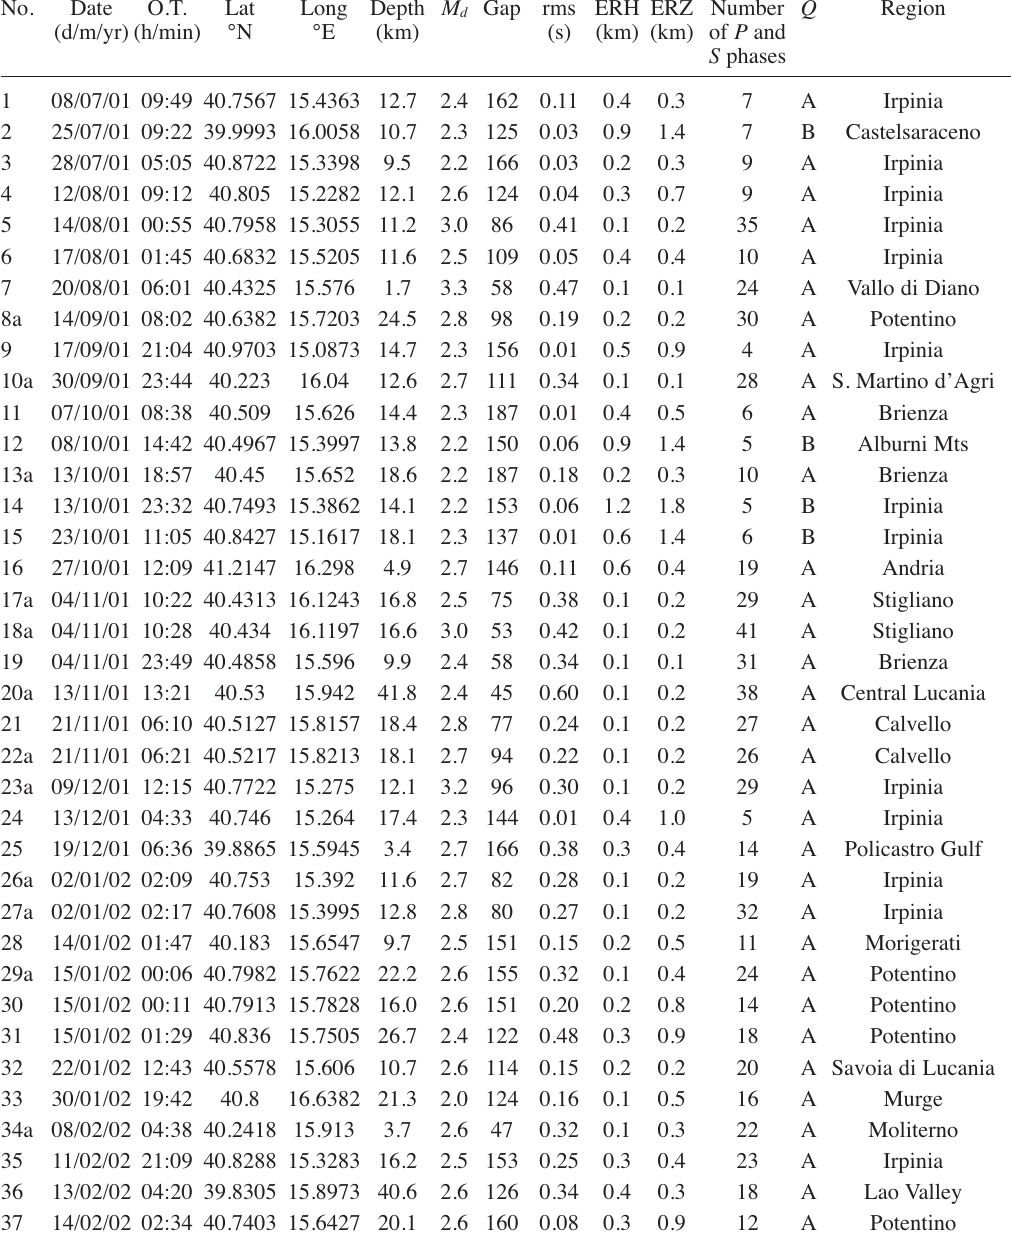
Table III. Hypocentral parameters, duration magnitude, azimuthal gap, location errors (rms, ERH, ERZ), total number of P- and S- phases used for location, location quality and geographic area of the 120 earthquakes select- ed in this